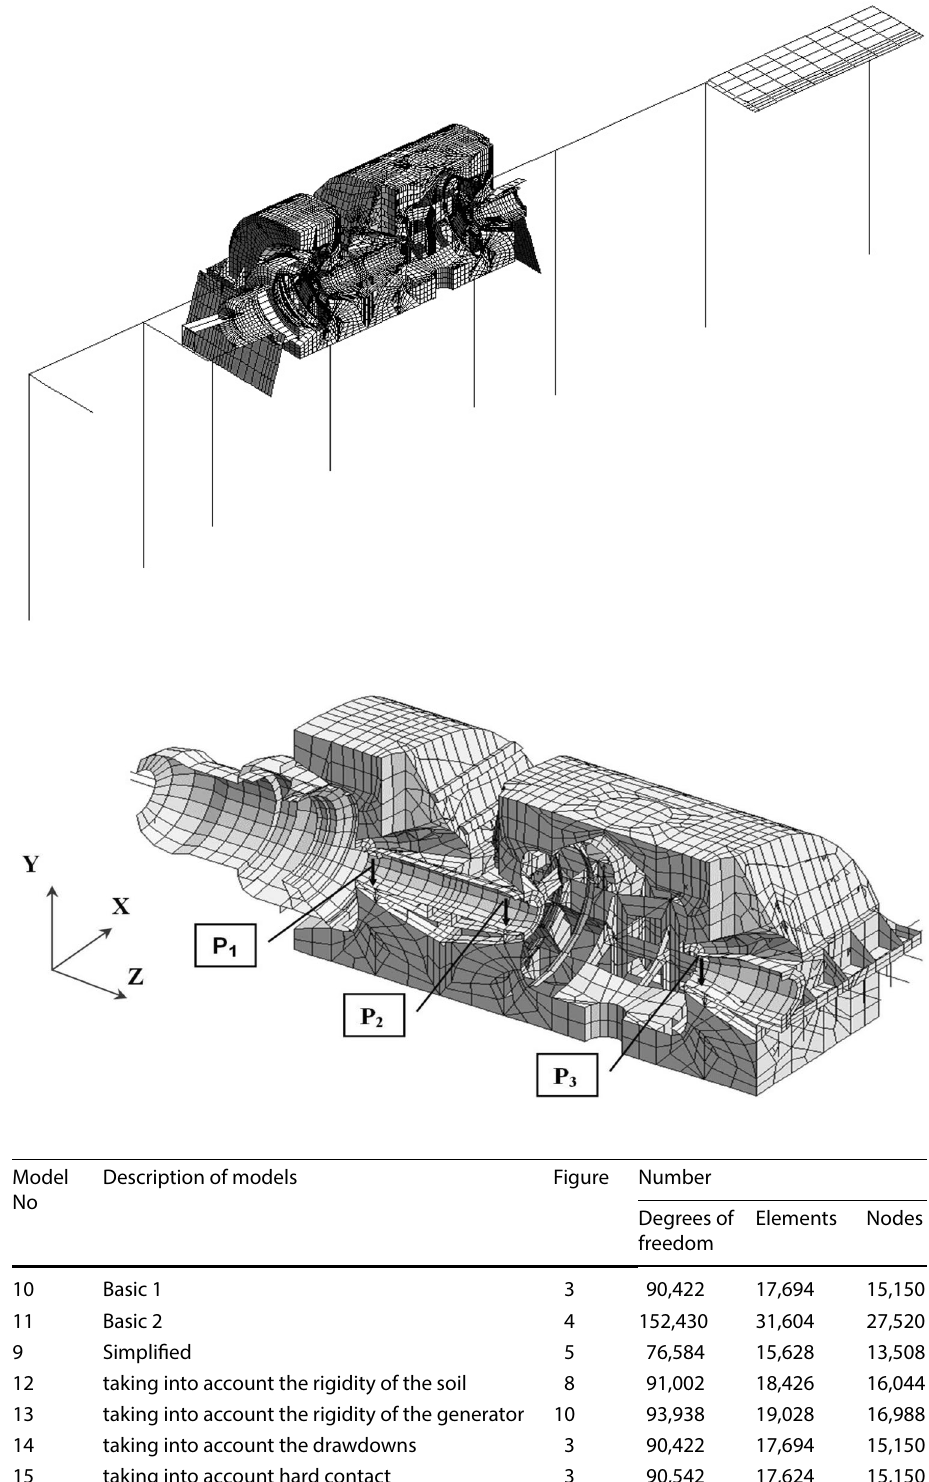
Degrees of Elements freedom